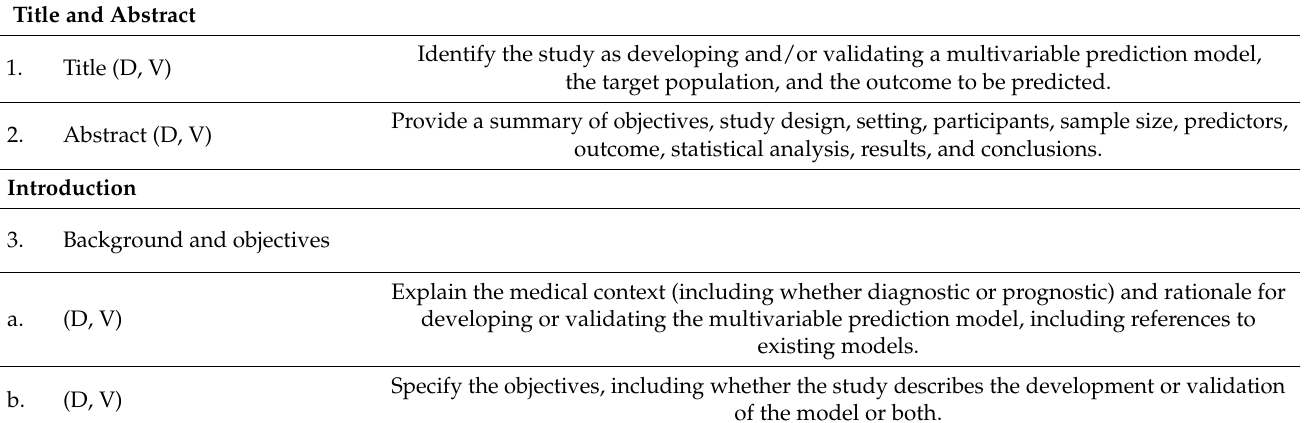
Table 1. Components of the Transparent Reporting of a multivariable prediction model for Individual Prognosis or Diagnosis (TRIPOD) statement adapted from www.tripod-statement.org/ (accessed on 21 December 2021). Items are numbered and subitems are marked with